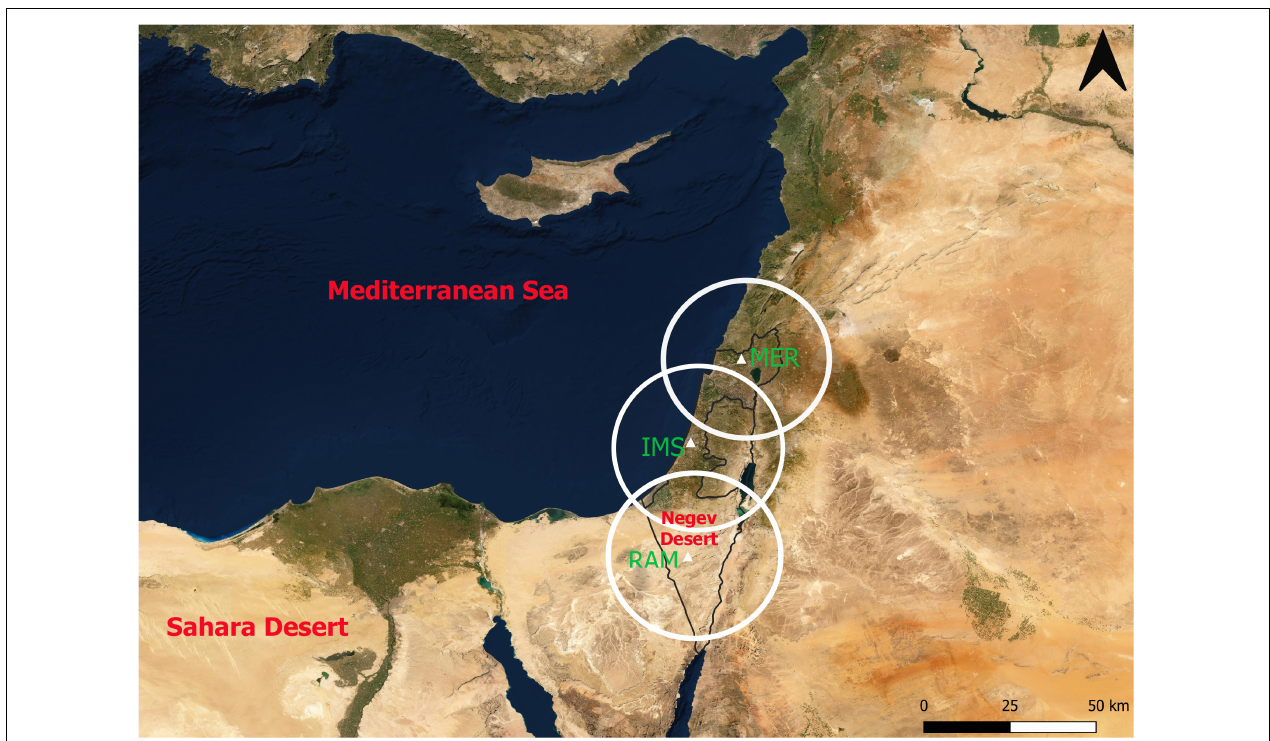
FIGURE 1 | Satellite imagery of the study area with the weather radars (white triangles), their 100-km-radius coverage (white circles) and international borders (black lines). The ecological barriers in the study area are the Mediterranean Sea to the west of Israel and the northern fringes of the Saharo-Arabian desert belt that includes the Negev Desert in the southern part of country. Please note the transition from a desert environment in the south of the country (sandy colors in the image) to Mediterranean-type scrub vegetation in the center and northern parts of the country that is greener in